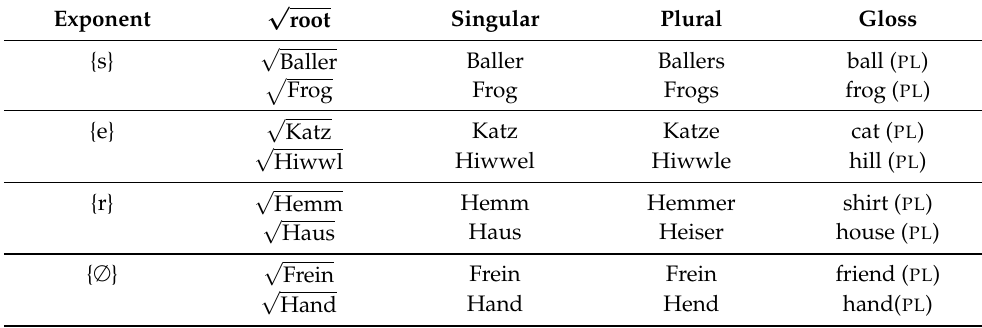
Table 3. Pennsylvania Dutch Plural exponent